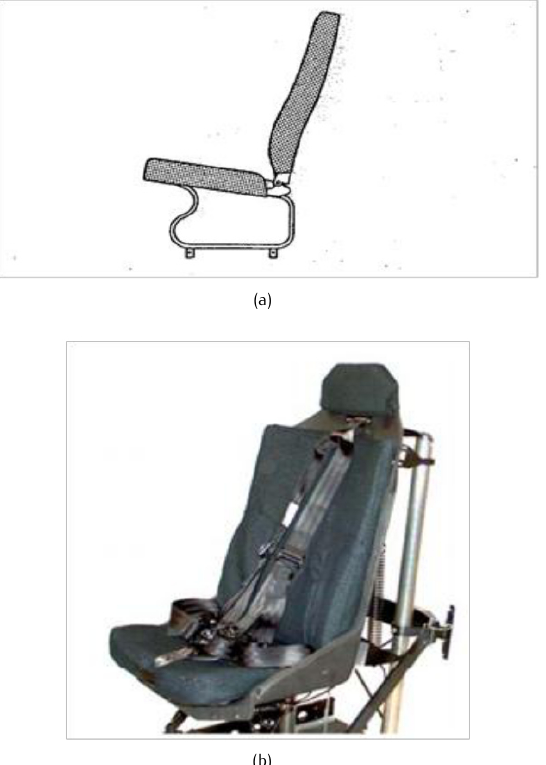
Figure 1. (a) seat with energy-absorbing legs [21], (b) cockpit seat with monolithic bucket [4].